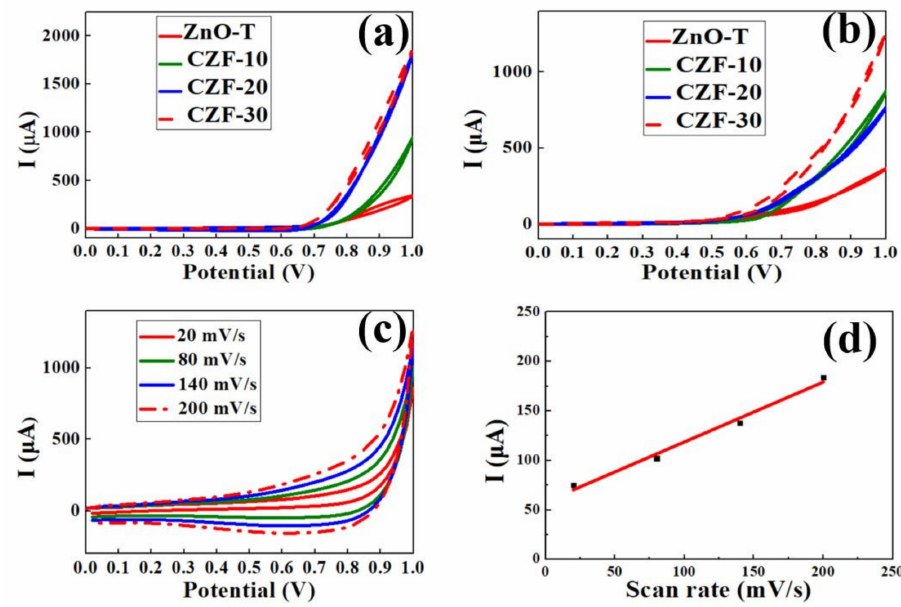
Figure 3. ( a ) CVs of ZnO-T electrode (red), CZF-10 (green), CZF-20 (blue), CZF-30 (red dotted line) run at 100 mV/s in 0.1 M NaOH ( b ) CVs of ZnO-T electrode (red), CZF-10 (green), CZF-20 (blue), CZF-30 (red dotted line) run at 100 mV/s in 0.1 M NaOH add 0.1 mM glucose. ( c ) CVs of the CZF-30 in 0.1 M NaOH containing 1 mM glucose at different scan rates from 20 to 200 mV/s. ( d ) shows the anodic peak current vs. scan